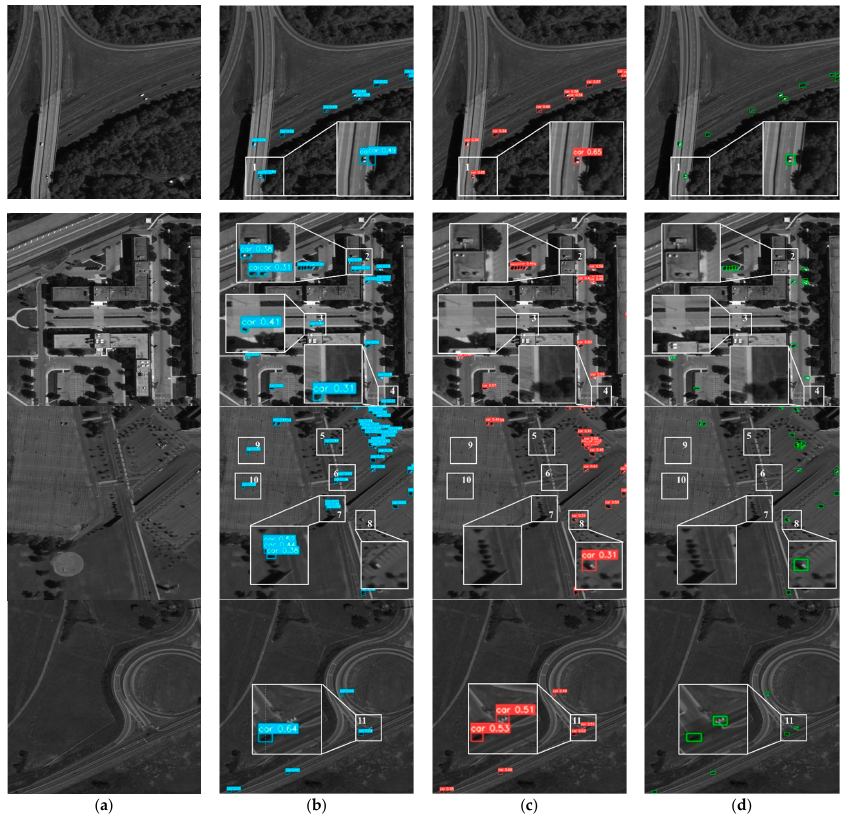
Figure 8. ( a ) Input image, ( b ) CenterNet, ( c ) our method, and ( d ) ground truth. Visualization of the